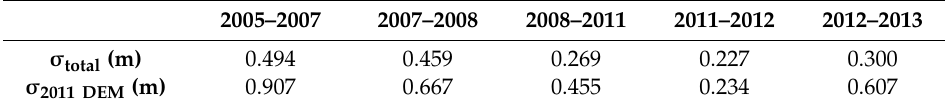
Table 4. Accuracy evaluation of two terrain datasets obtained from two successive